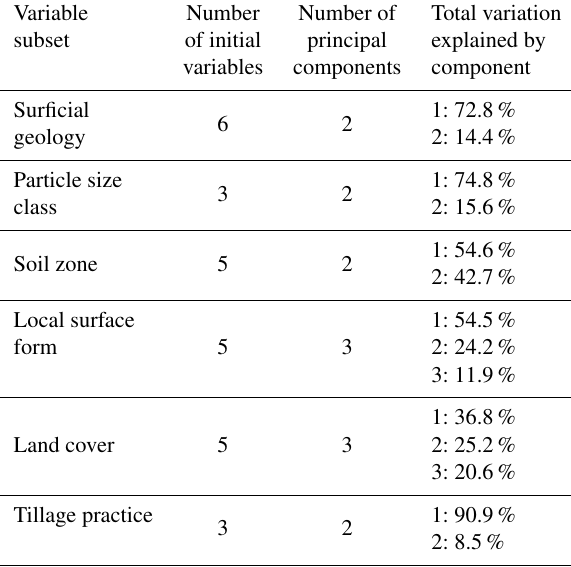
Table 1. Pre-processing of compositional data PCA results. Shown are the respective subsets, the number of initial fractional area vari- ables before dimensional reduction, the number of principal com- ponents retained to reach over 80% of subset variation (except for tillage practice), and the proportion of variation explained by each component.